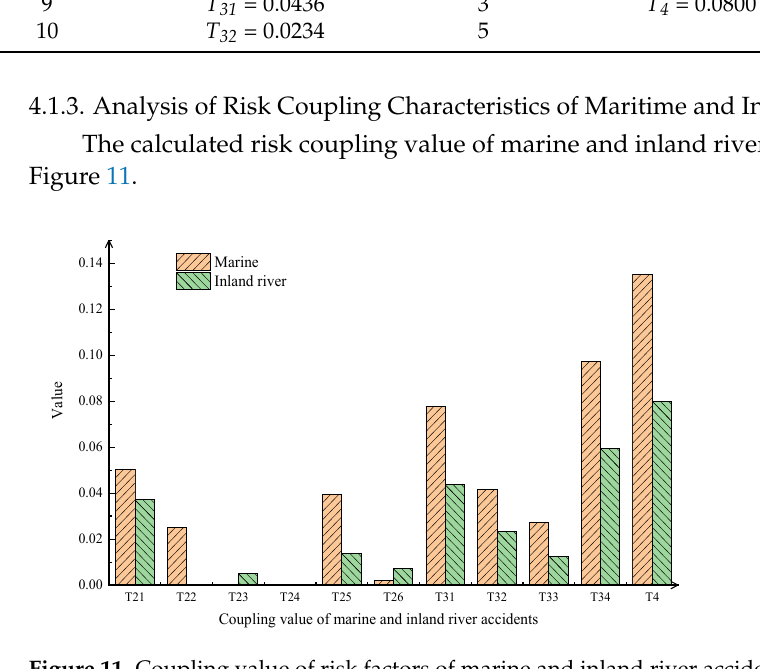
Figure 11. Coupling value of risk factors of marine and inland river accidents.